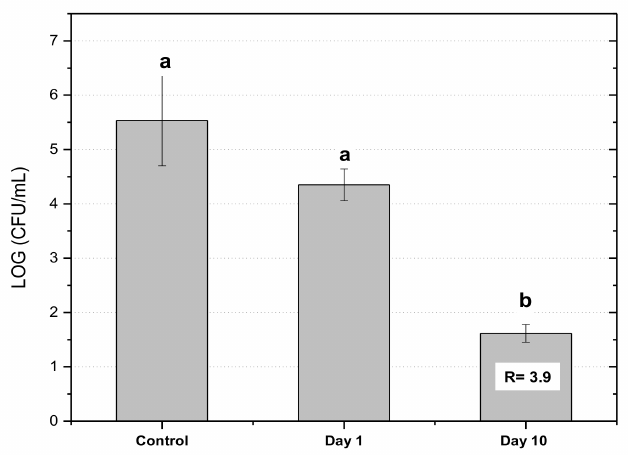
Figure 7. Antimicrobial activity of (PCL+OR)-GEL-(PCL+OR) film on 1 and 10 days’ storage against S. aureus CECT 240 after 24 h exposure. Different letters (a-b) indicate significant differences ( p < 0.05) among samples. R correspond to the value of the antimicrobial